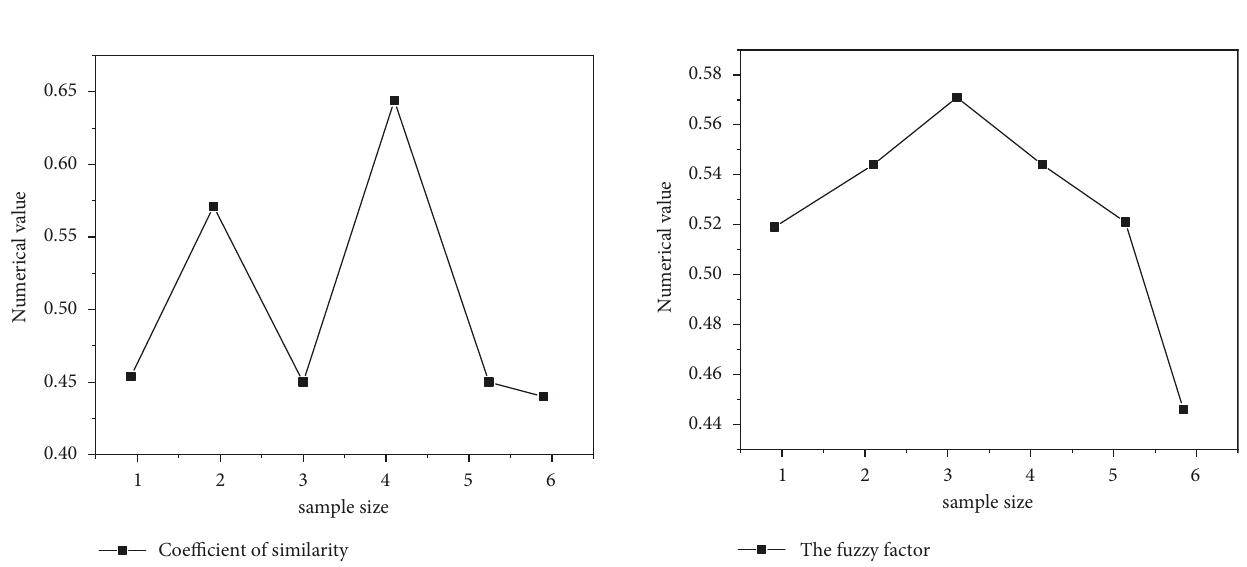
Figure 7: Blur factor results of sample